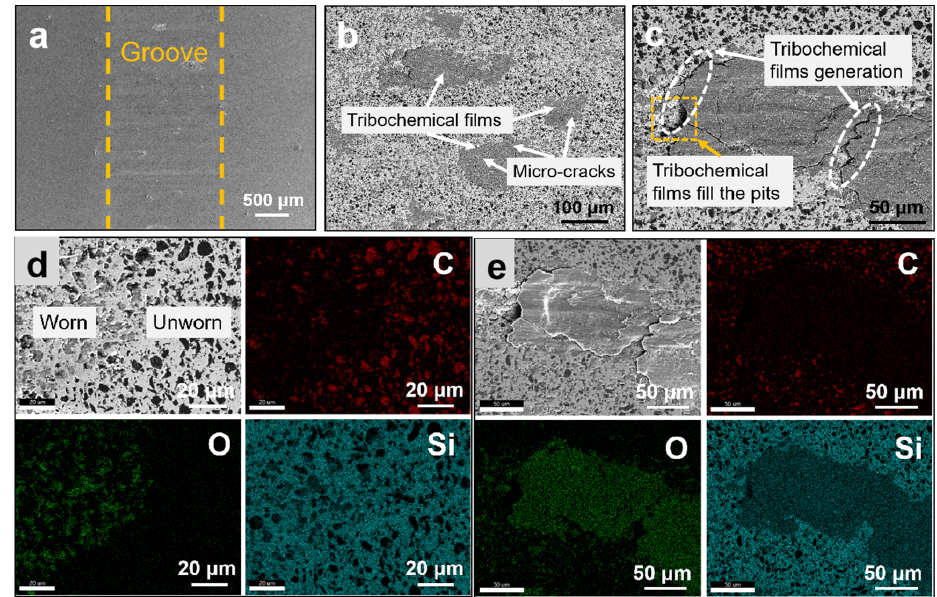
Figure 7. Friction surface morphology of R-MS composites: ( a ) low magnification; ( b,c ) high magnification; ( d,e ) EDS analysis.